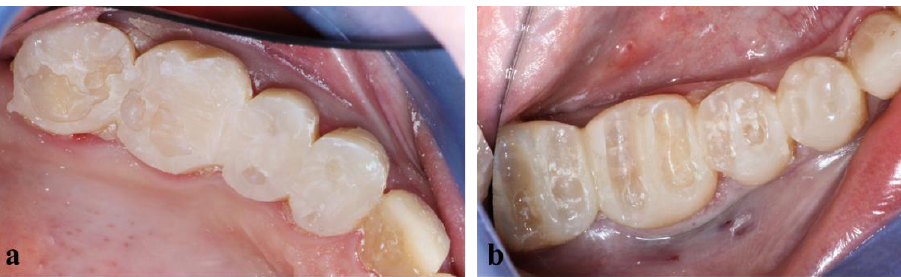
Figure 8. Teeth preparation through the mock-up of upper ( a ) and lower ( b ) right premolars and molars.